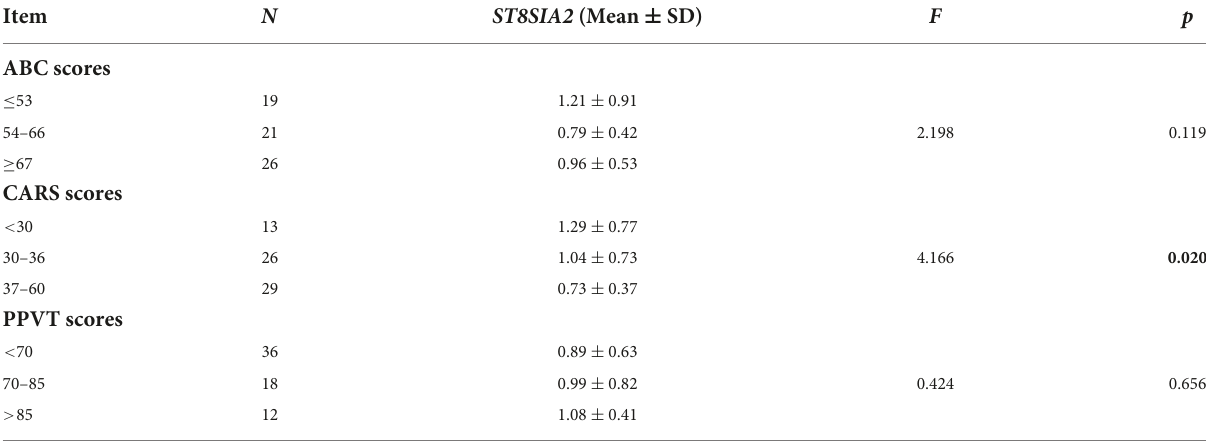
TABLE 1 Relationship between the severity and intelligence development of autistic children and the ST8 alpha-N-acetyl-neuraminide alpha-2,8-sialyltransferase 2 (ST8SIA2) mRNA levels.